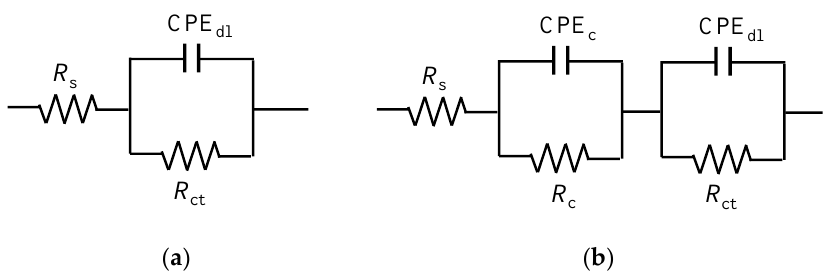
Figure 7. Equivalent electrical circuit: ( a ) uncoated steel rebar and ( b ) enamel-coated steel rebar.